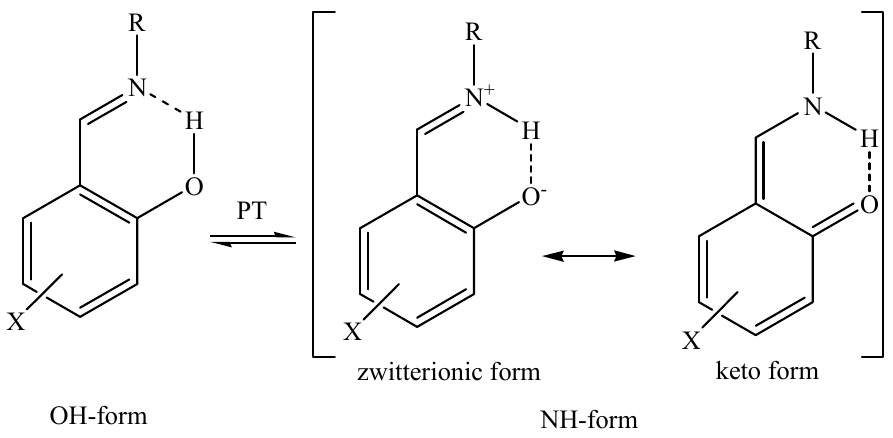
Figure 1. Proton transfer equilibrium in Schiff bases.